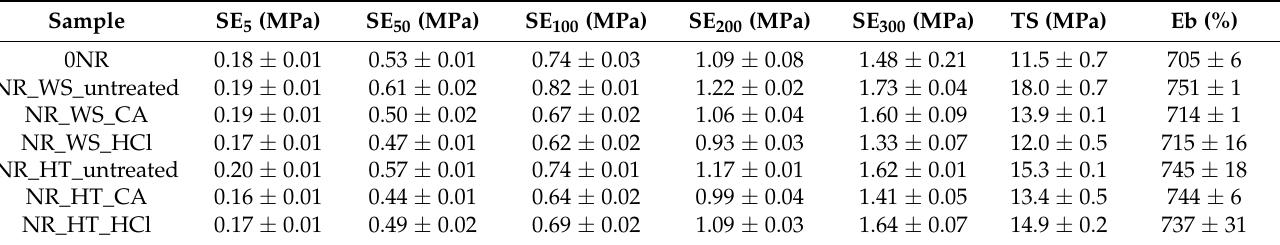
Table 6. Mechanical properties of vulcanizates filled with